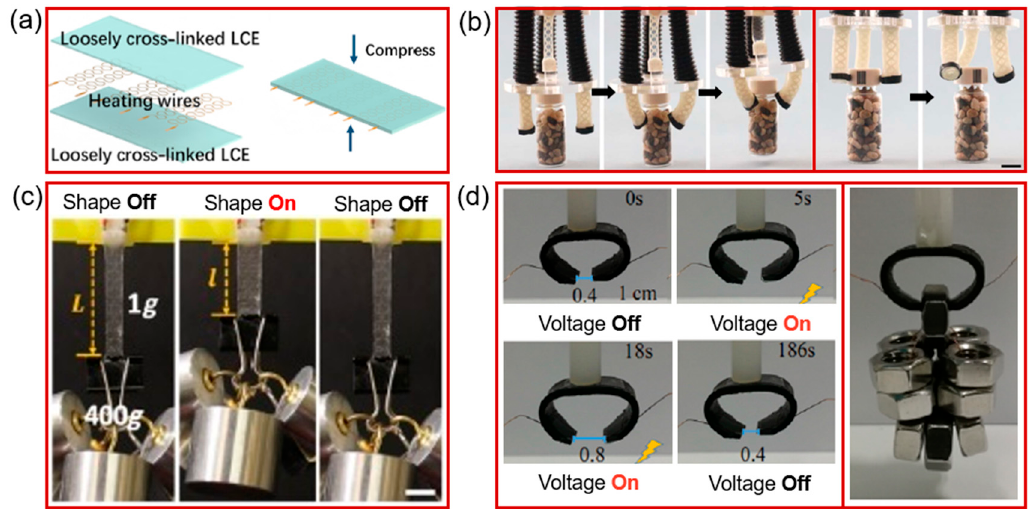
Figure 13. ( a ) Fabrication steps of an LCE-based tubular actuator with three serpentine heating wires sandwiched between two layers of loosely cross-linked LCE film. ( b ) An LCE artificial muscle film that could lift a load of 3.92 N by 38% of its initial length. ( c ) Schematic of the soft gripper and grasping and lifting of the vial (50 g) and twisting the cap of a vial (Reprinted (adapted) from Science Advances, Applied Sciences and Engineering [142]. Copyright (2019), American Association for the advancement of Science). ( d ) Schematic of the PEO/S-CNT composites used to grasp and release an object with the voltage on (36 dc) and off with a picture of the gripper for grabbing nuts (Reprinted (adapted) with permission from Xu et al. [124] . Copyright (2019) American Chemical Society).